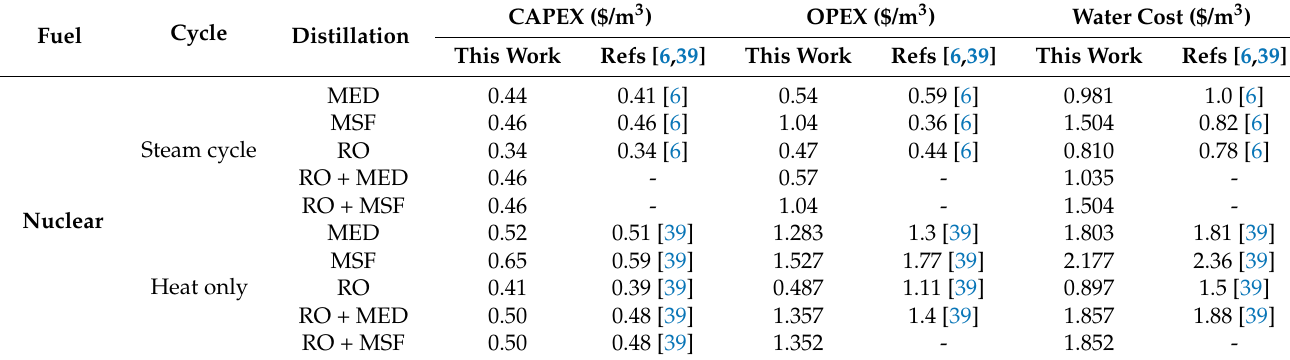
Table 6. Capital and operating cost of water with and without electricity.